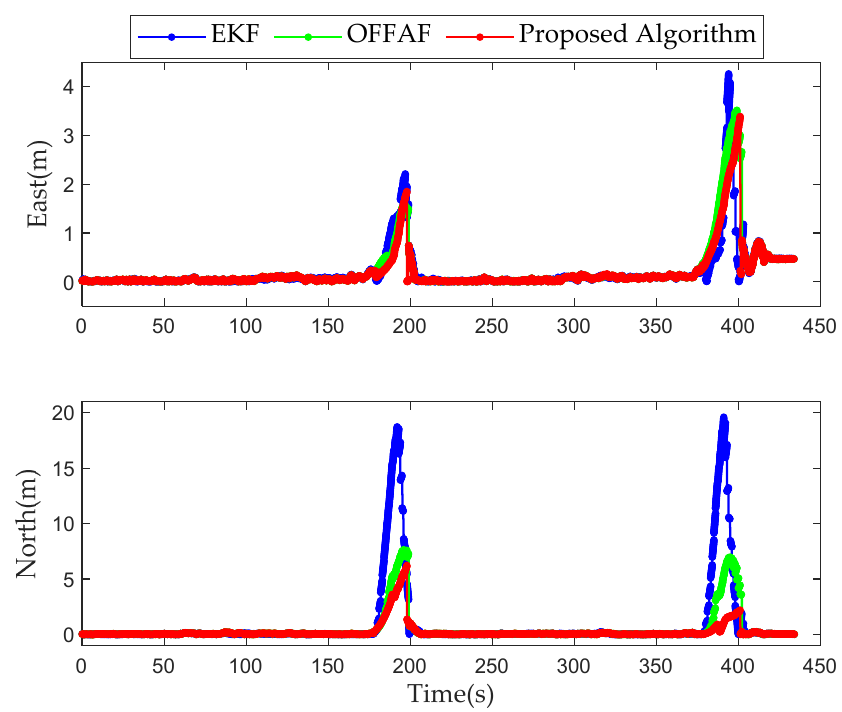
Figure 25. Positioning errors of the proposed algorithm in the east and north in case two. Table 7. The GNSS/INS integrated positioning performance of the EKF, OFFAF and the proposed algorithm.